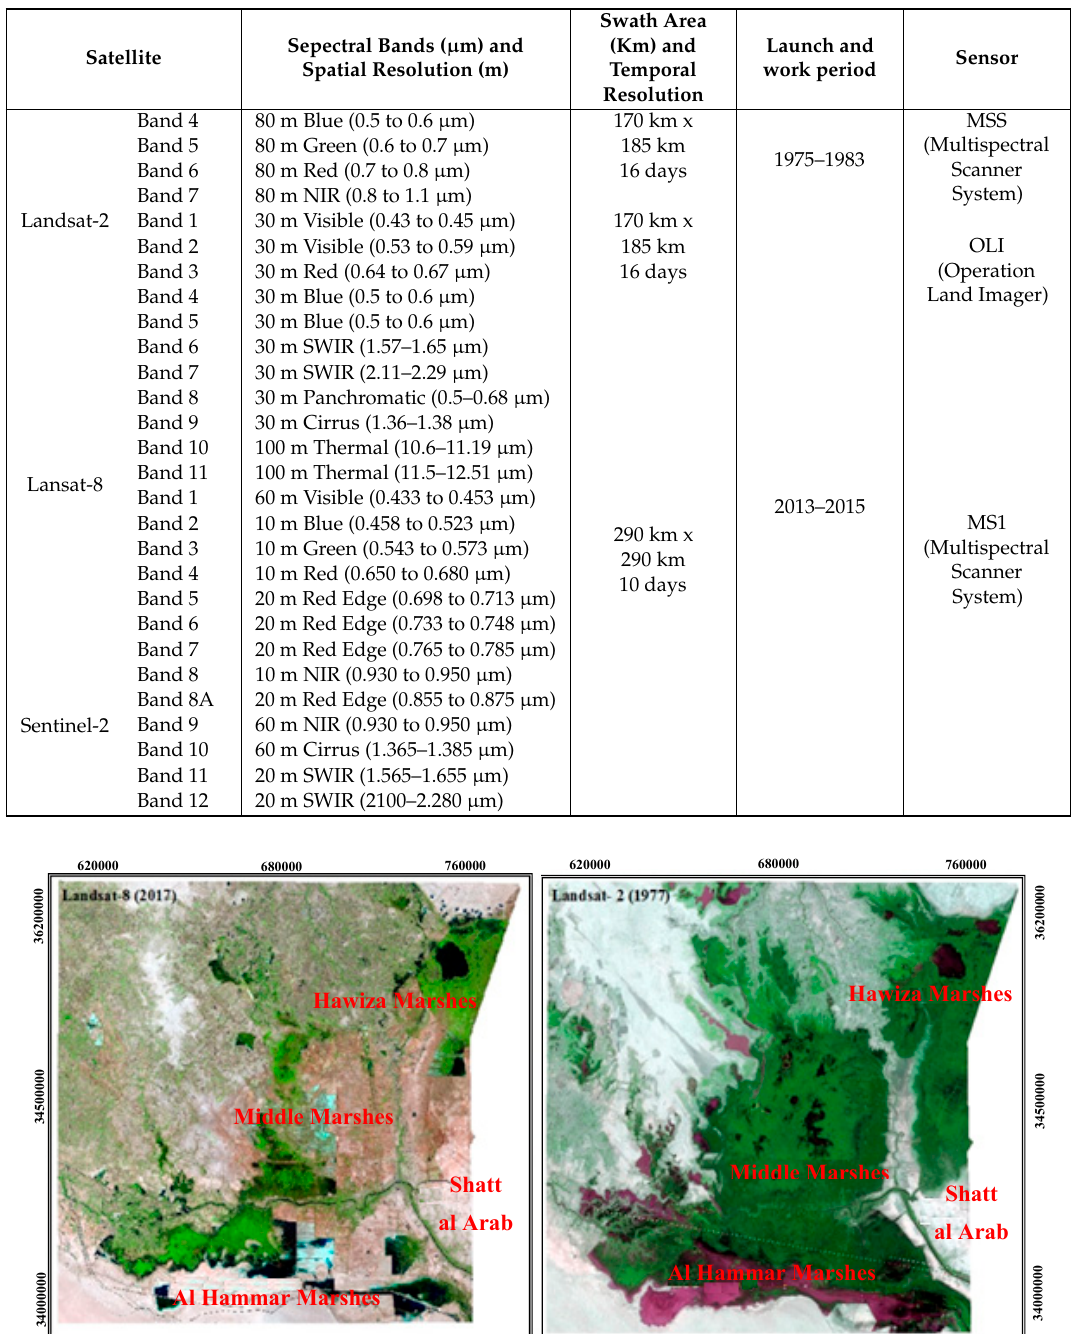
Table 1. Characteristics of Landsat 2, 8 and Sentinel 2 satellites [20,21].